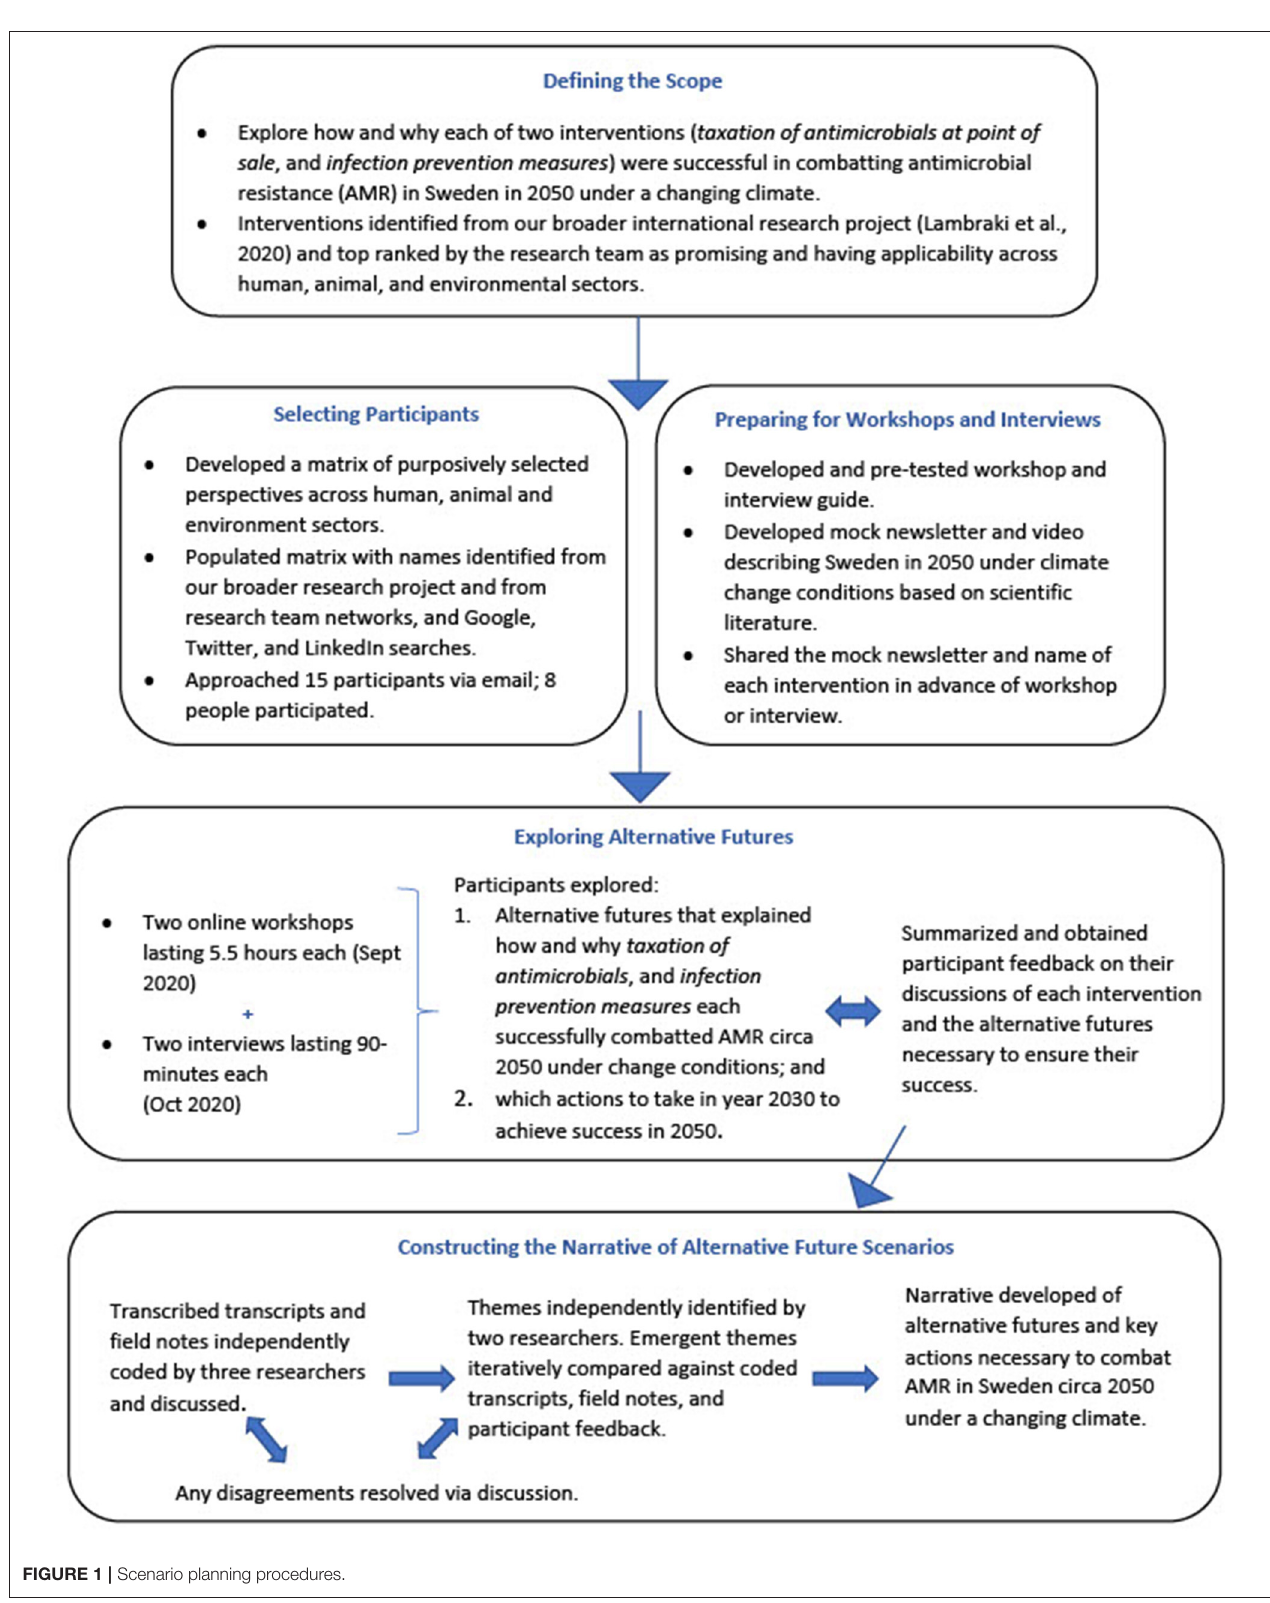
FIGURE 1 | Scenario planning